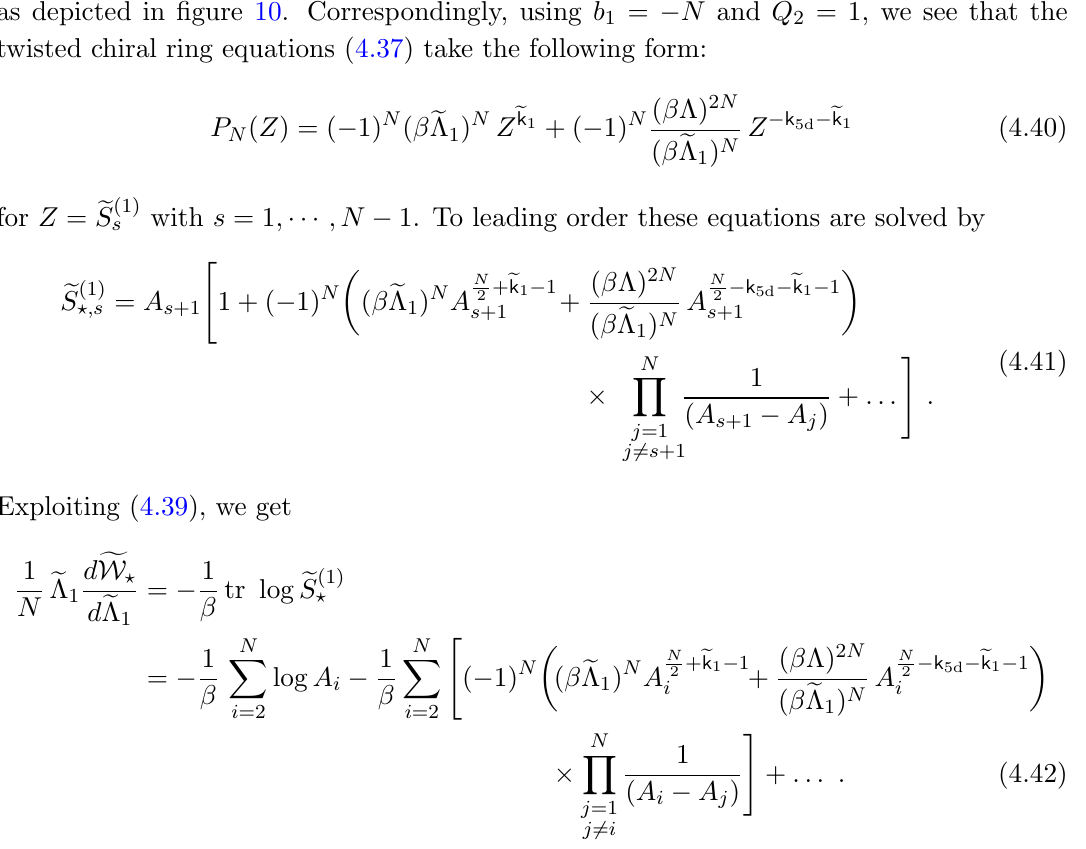
Figure 10 . The dual quiver for the [1 ; N (cid:0) 1] defect in the SU( N ) theory. Simple surface